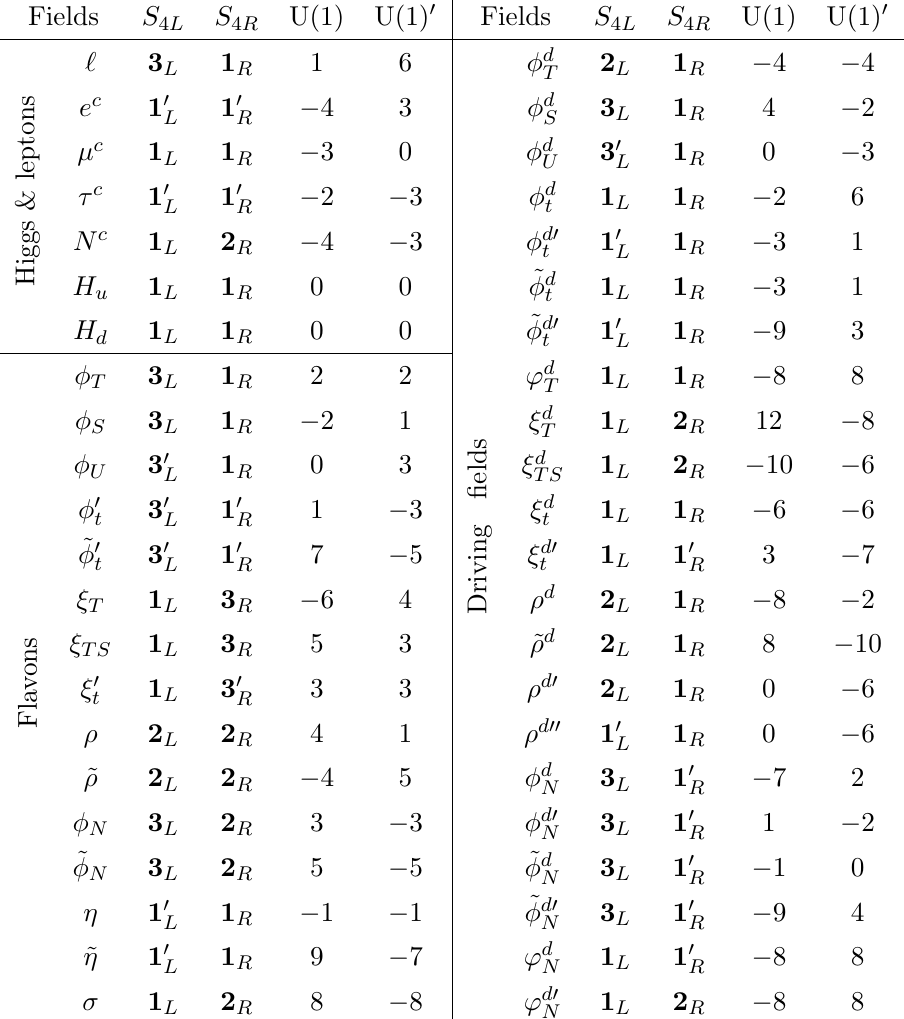
Table 1 . Field arrangements of the (cid:22)(cid:28) -LSS model in S 4 L (cid:2) S 4 R (cid:2) U(1) (cid:2) U(1) 0 . In addition, we assume a standard U(1) R symmetry with the charge assignments: +1 for lepton, 0 for Higgs and (cid:13)avon (cid:12)elds, and +2 for driving